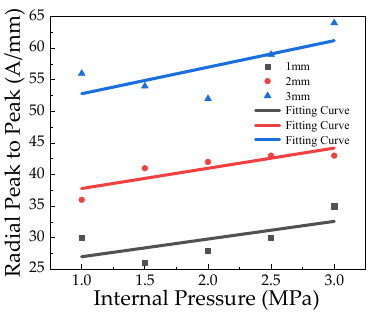
Figure 17. Radial peak-to-peak of weak magnetic signals of different crack depths with internal pressure. And the deeper the crack depth is, the faster radial peak-to-peak of magnetic weak signal changes with the internal pressure.